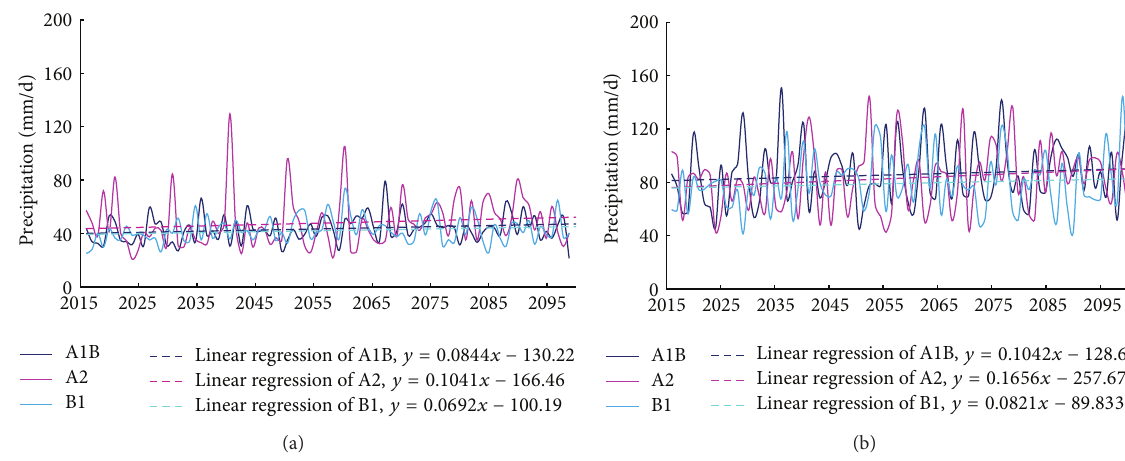
Figure 9: Extreme precipitation changes from 2016 to 2100 under three climate change scenarios: (a) RX1day and (b) RX3day.